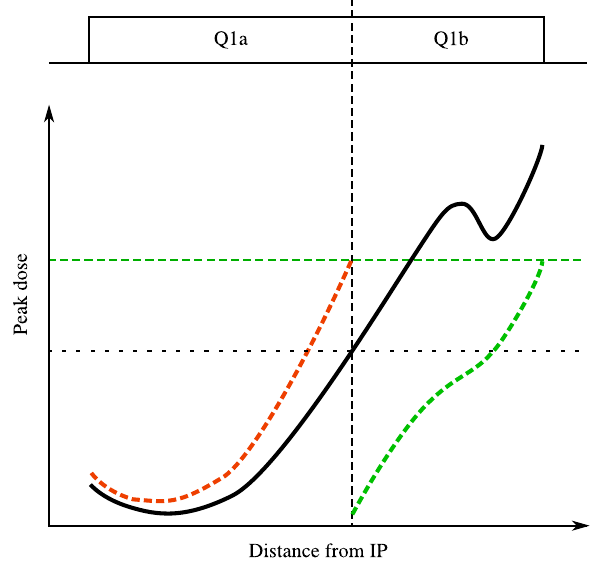
FIG. 16. Qualitative sketch of the peak dose in the Q1. The horizontal axis extends over the length of Q1(a/b) shown at the top. The black line describes the peak dose for an unsplit Q1. The expected changes for splitting Q1 are shown by the dashed red and green